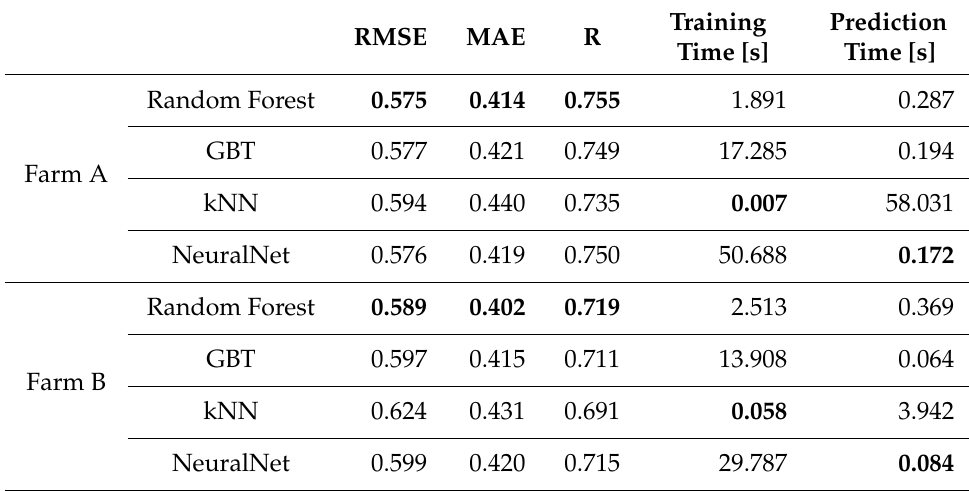
Training Prediction Time [s] Time [s]